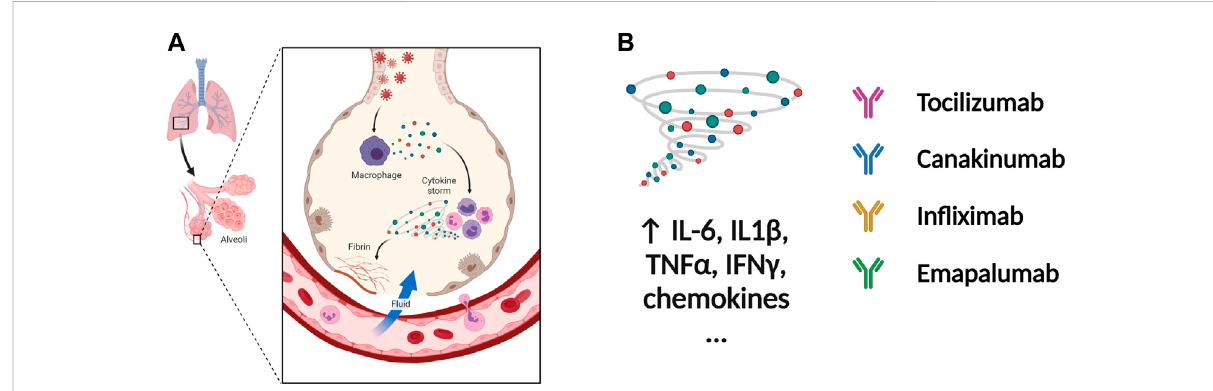
FIGURE 4 Potential therapeutic regimens targeting the immune system and cytokine storm. (A) The SARS-CoV-2 infected cells will secrete great amounts of chemokines or cytokines, which recruit immune cells including macrophages. The cytokine storm is caused by uncontrolled immune response that immune cells continuously activate, expand, and produce immense amounts of cytokines. The in fl ammation will damage the lung cells followed by the formation of fi brin and accumulation of fl uid seeping into the lung cavities, leading to the failure of gas exchange. (B) The nAbs targeting IL-1 β , IL-6, TNF- α , and IFN- γ among others have been tested in patients with severe COVID-19. in fl ammation. Figure was generated by